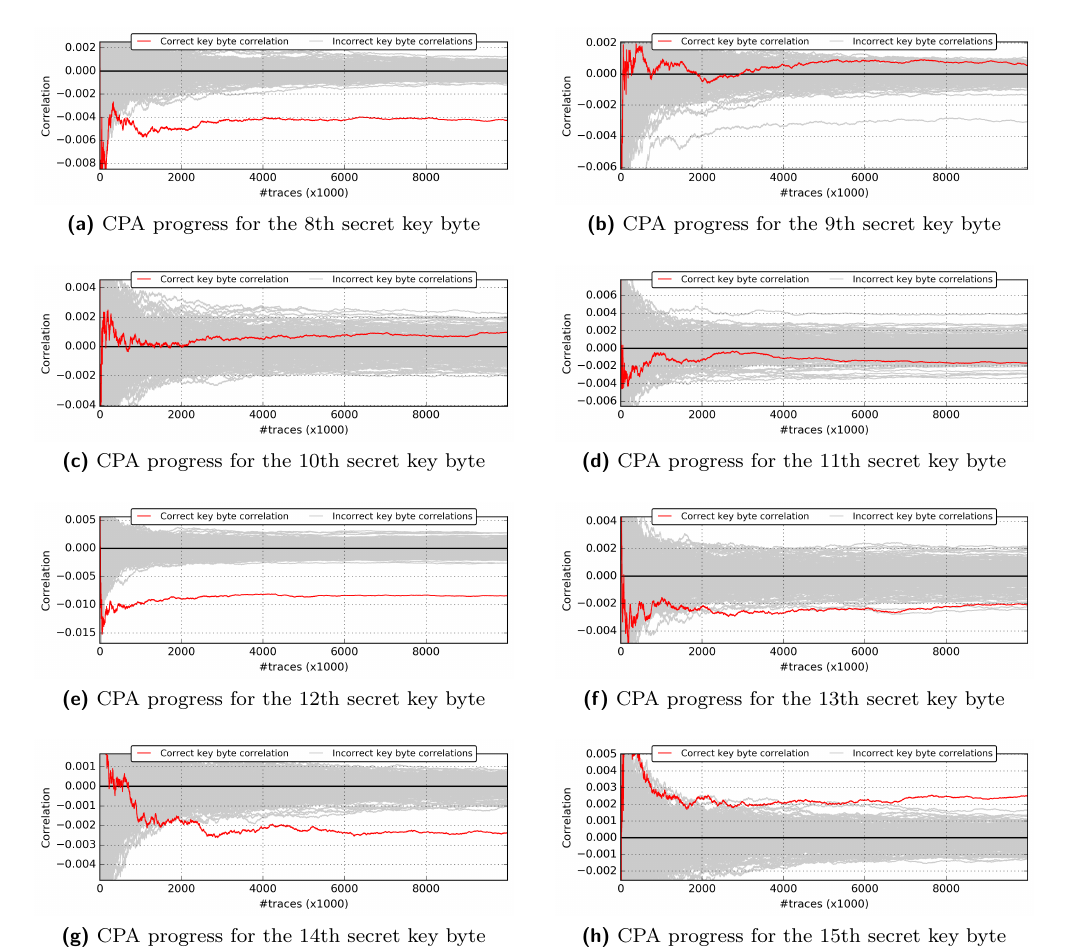
Figure 24: Results of a CPA attack on the last secret round key (bytes 8 to 15) of AES on the STM32F407VG Discovery #2 @168MHz with the ADC connected to Vdd and the program compiled with the -O0 optimization option. Each plot shows the correlation progress of all 256 key candidates for a specific key byte over 10 M traces and the respective correct key candidate is marked